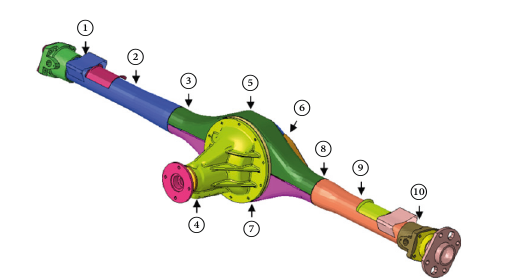
Figure 9: Sketch of the accelerometers’ locations.